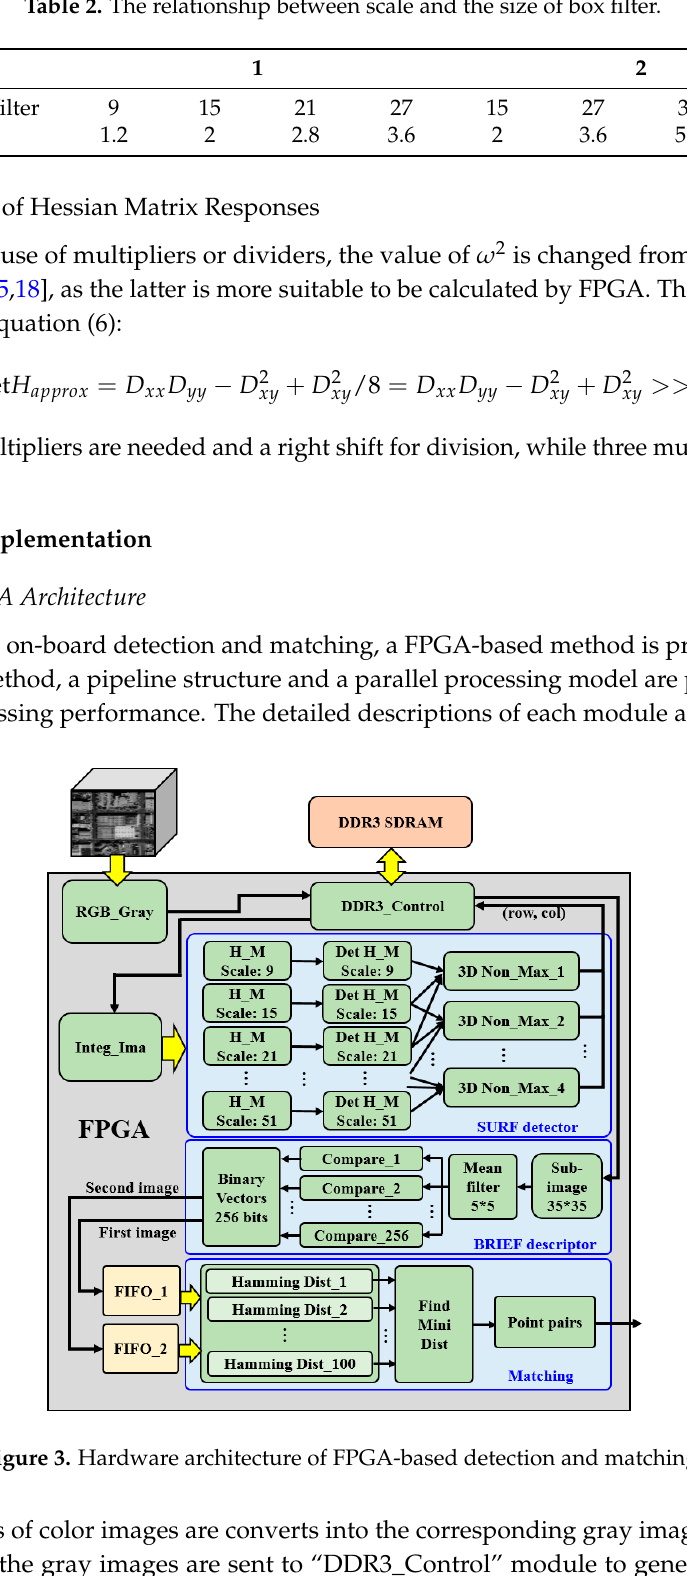
Table 2. The relationship between scale and the size of box filter.